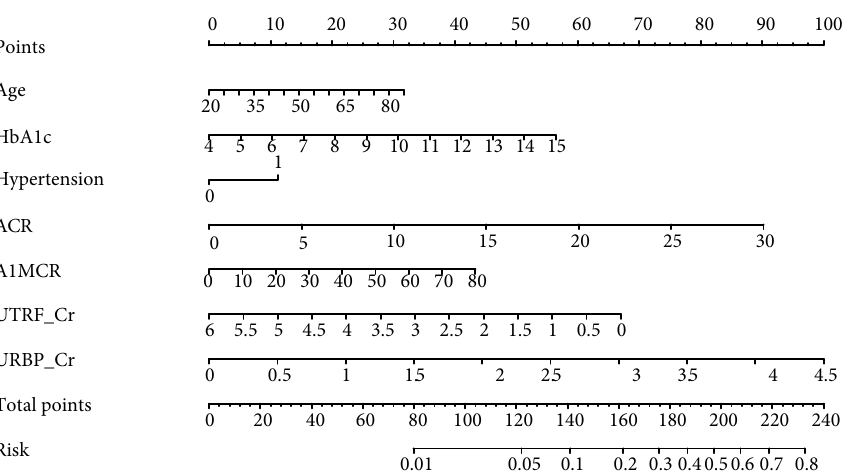
Figure 4: Nomogram for prediction of new-onset renal dysfunction risk. Hypertension 0: patients without hypertension; Hypertension 1: patients with hypertension; ACR: albumin-to-creatinine ratio; HbA1c: glycated hemoglobin; A1MCR: alpha-1-microglobulin-to-creatinine ratio; UTRF_Cr: transferrin-to-creatinine ratio; URBP_Cr: retinol-binding protein-to-creatinine